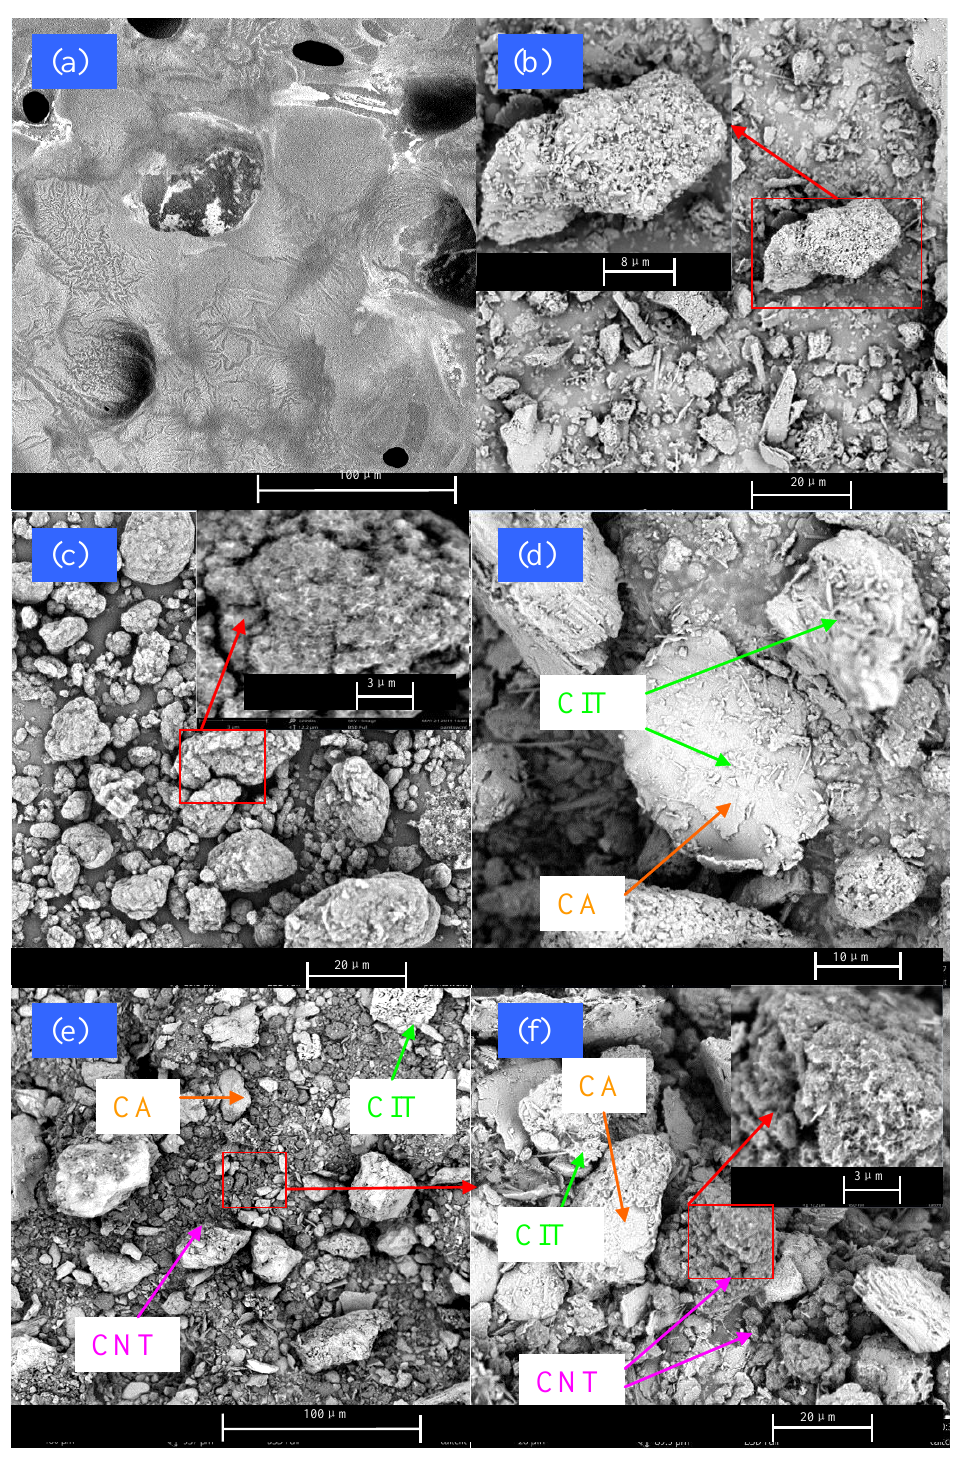
Figure 7. SEM photographs of CA ( a ), CIT ( b ), CNT ( c ), CA/CIT ( d ), CA/CIT/CNT, ( e ) and ( f